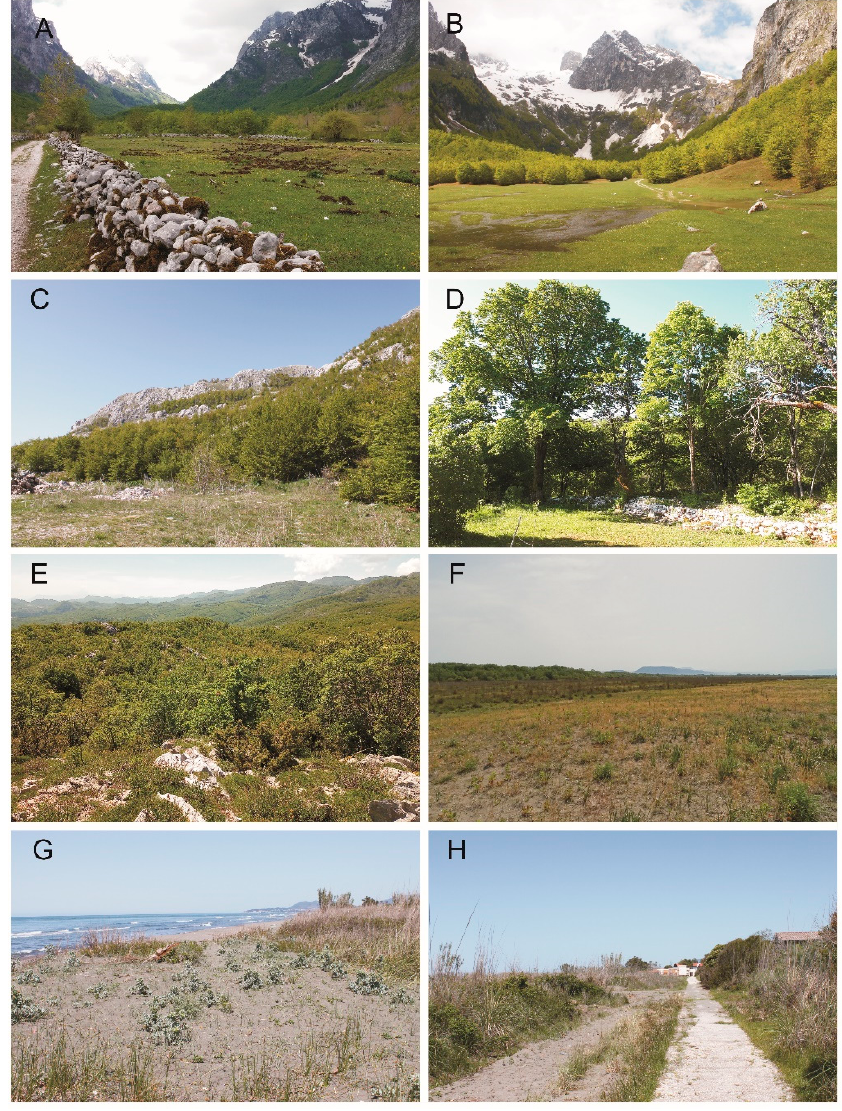
Figure 4. Collection localities of the scarabaeoid beetles in Montenegro (2019, 2021): ( A )—Vusanje at Gusinje, ( B )—Grebaje at Gusinje, ( C )—Žanjev Do at Njeguši, ( D , E )—Dubovik at Cetynia, ( F )—Doni Štoj at Ulcinj (dunes), ( G , H )—Bojana at Ulcinj (Photos: ( A )—Tomasz Gazurek, ( B , C , G , H )—Sebastian Tylkowski, ( D , F )—Adam Byk and ( E )—Marek Bidas).